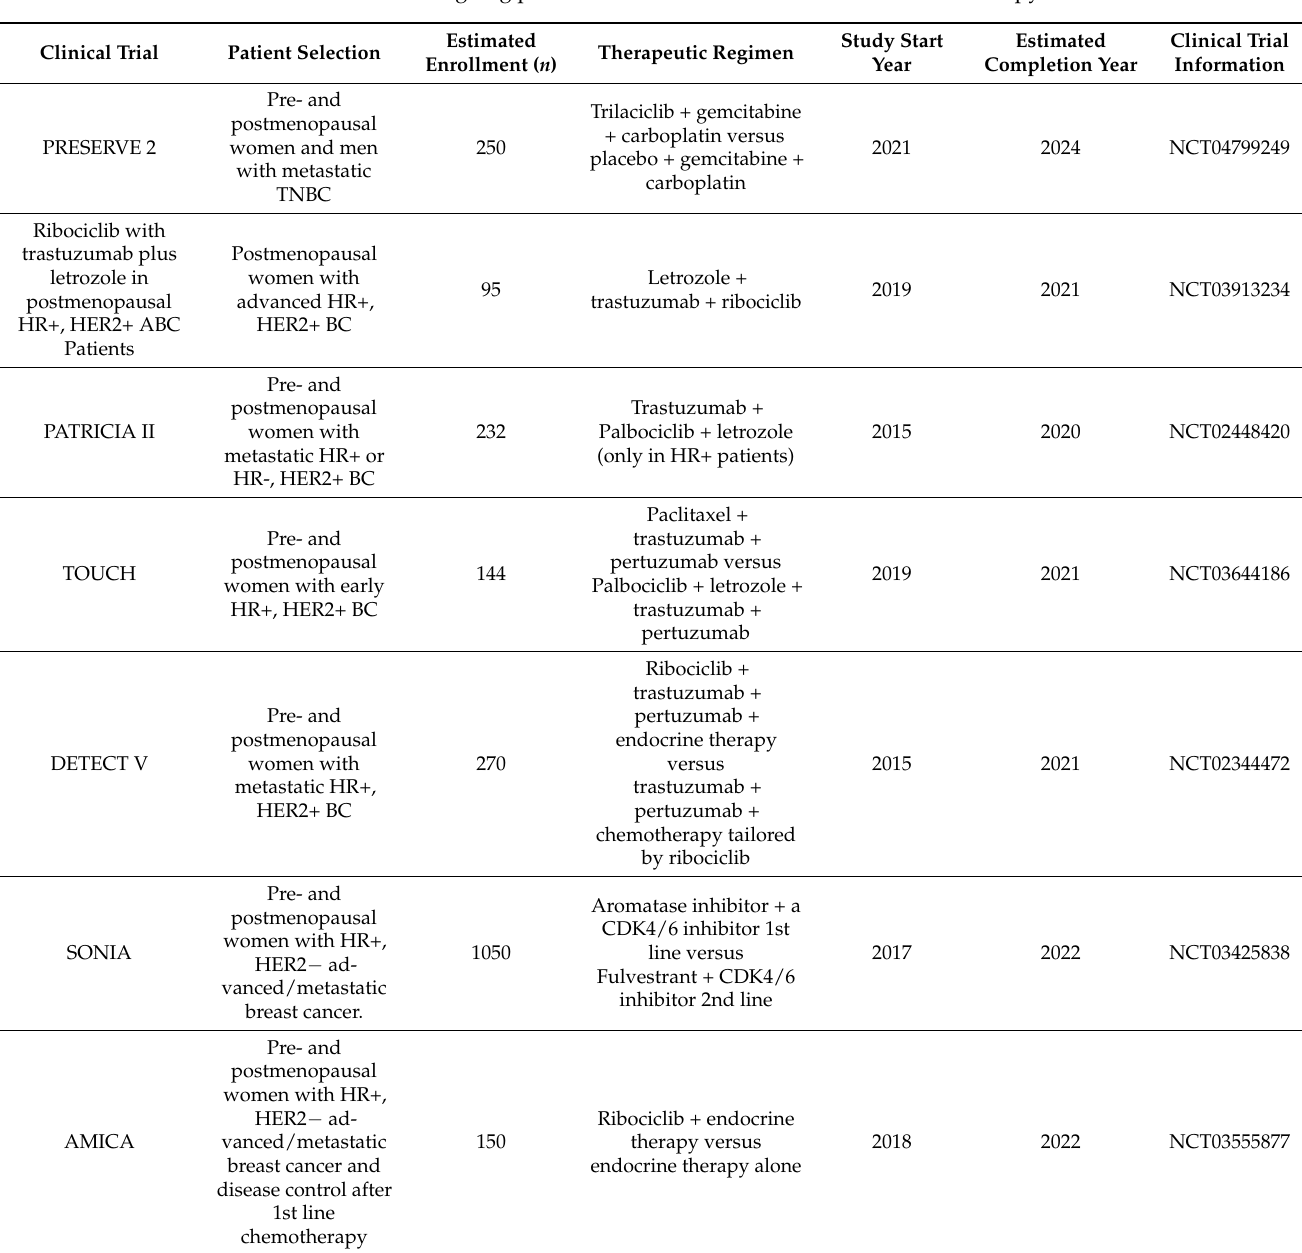
Table 2. Selected ongoing phase II and III trials with CDK4/6 inhibitor